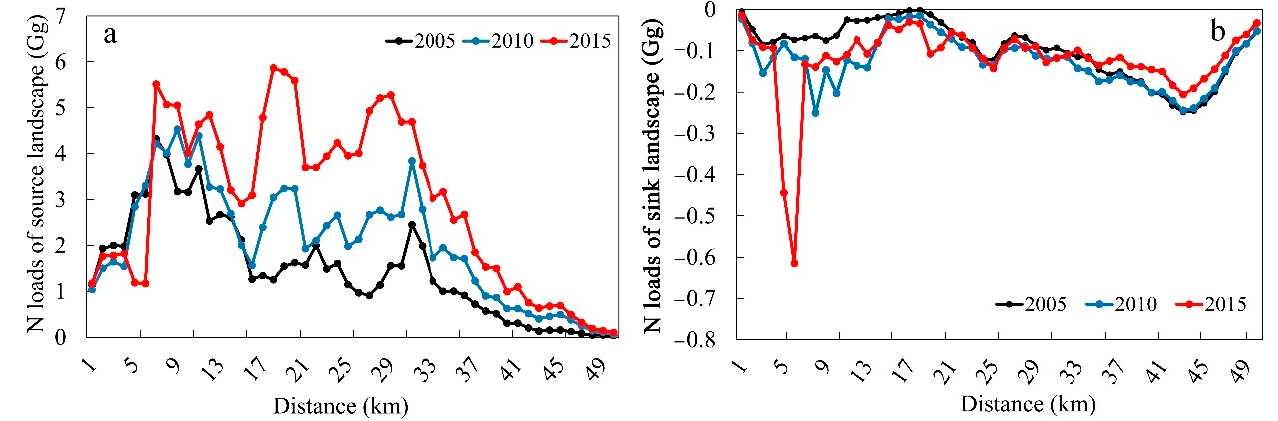
Figure 6. Nitrogen loads of source and sink landscapes along the spatial gradient (( a ): source landscape; ( b ): sink landscape ) .